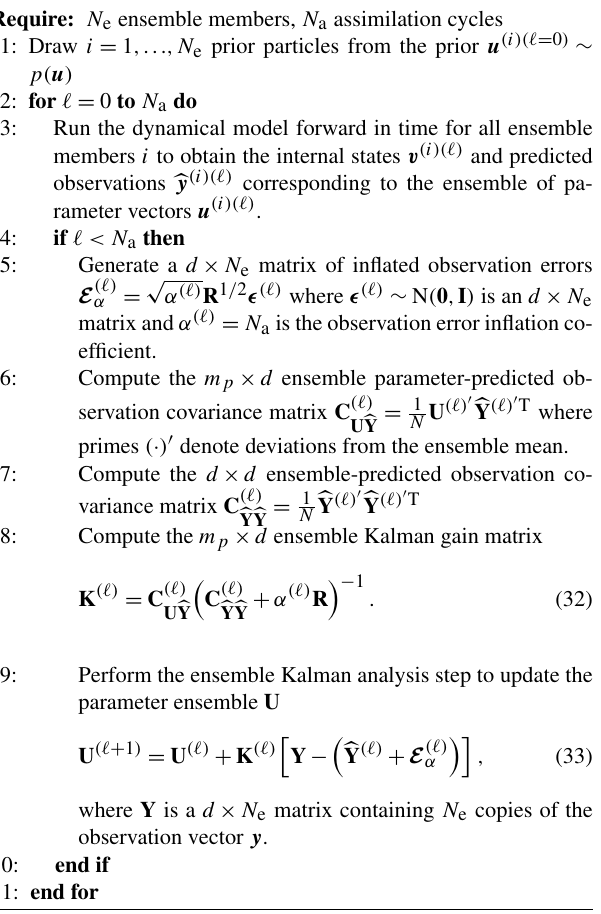
Algorithm 3. For clarity, this pseudocode also omits